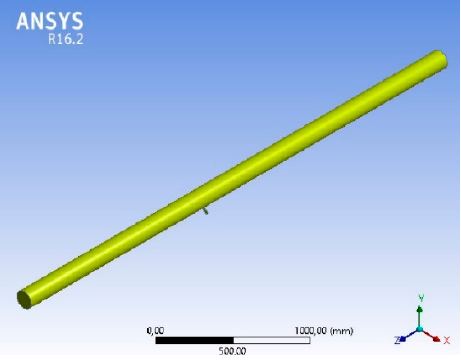
Figure 3. Geometric model of the PVC-A with transversal orifice implemented in Ansys environment.